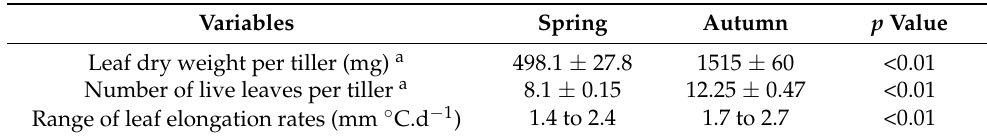
Table 1. Differences in plant shoot development in spring and autumn experiments. Statistical difference between spring and autumn was tested using one-way